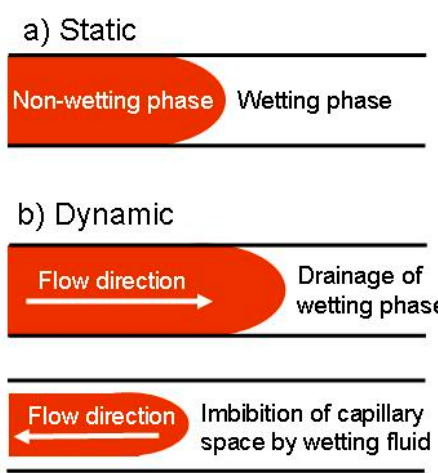
Figure 14. ( a ) Two-phase fluid contact with surface tension between non-wetting phase (e.g., oil) and wetting phase (e.g., water). ( b ) Piston-like movement occurs when non-wetting fluid (oil) sweeps the wetting fluid.